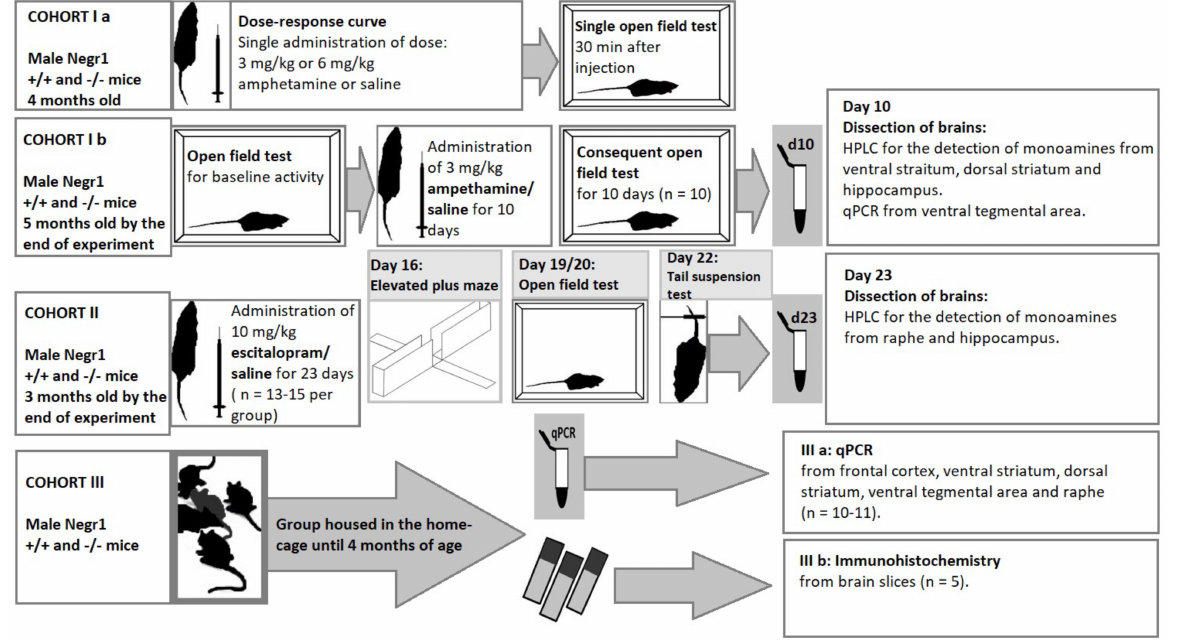
Figure 1. Schematic overview of the cohorts of mice and tests/measurements performed in the current study. For the estimation of the treatment of acute and chronic amphetamine (cohort I), two subgroups of mice were used: cohort Ia for the estimation of the dose curve (data shown in Supplementary Figure S1) and cohort Ib for the chronic amphetamine administration. An open field test for baseline activity of cohort Ib mice was performed 7 days before the administration of amphetamine. Cohort II was used for the estimation of the treatment of chronic escitalopram and cohort III was used for baseline measurement of gene expression and IHC